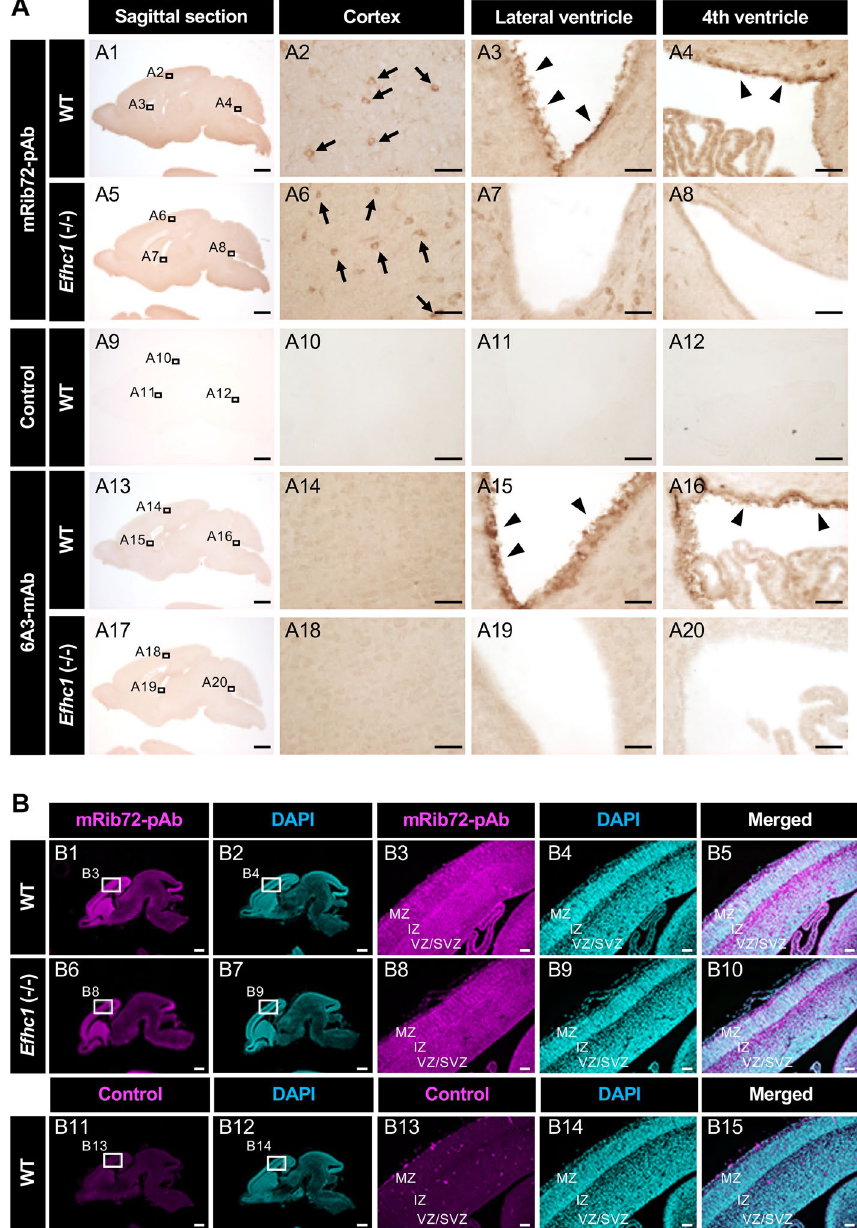
Figure 2. The mRib72-pAb, but not 6A3-mAb, shows immunosignals in neurons that remained in Efhc1 −/− mouse. ( A ) Sagittal brain sections from postnatal day 14 (P14) WT and Efhc1 −/− mice were DAB-stained with mRib72-pAb (top two rows) or 6A3-mAb (bottom two rows) (two independent experiments, N = 1 WT and 1 Efhc1 −/− ). The mRib72-pAb showed immunosignals in neurons at cerebral cortex (arrows) in WT as reported previously 14,17 , but these signals remained in Efhc1 −/− mouse. The 6A3-mAb did not show signals in neurons. Both mRib72-pAb and 6A3-mAb revealed signals at ependymal motile cilia (arrow heads), and those well disappeared in Efhc1 −/− mouse. The normal rabbit IgG was used as a negative control (middle row). A2–A4, A6– A8, A10–A12, A14–16 and A18–20: magnified images outlined in A1, A5, A9, A13 and A17, respectively. ( B ) Sagittal brain sections obtained from E16.5 WT and Efhc1 −/− mice were stained with the mRib72-pAb (magenta) and DAPI (cyan) (two independent experiments, N = 1 WT and 1 Efhc1 −/− ). The mRib72-pAb immunosignals were observed in neurons at cerebral cortex from both WT and Efhc1 −/− mice. The normal rabbit IgG was used as a negative control (bottom row). B3, B4, B8, B9, B13 and B14: magnified images outlined in B1, B2, B6, B7, B11 and B12, respectively. B5, B10 and B15: merged images of B3–B4, B8–B9 and B13–B14, respectively. Scale bars = 1 mm (A; Sagittal section), 50 μm ( A ; Cortex, Lateral ventricle, and 4th ventricle), 500 μm ( B ; Sagittal section) and 50 μm ( B ; high-magnification images). VZ/SVZ ventricular zone/sub ventricular zone, IZ intermediate zone, MZ marginal